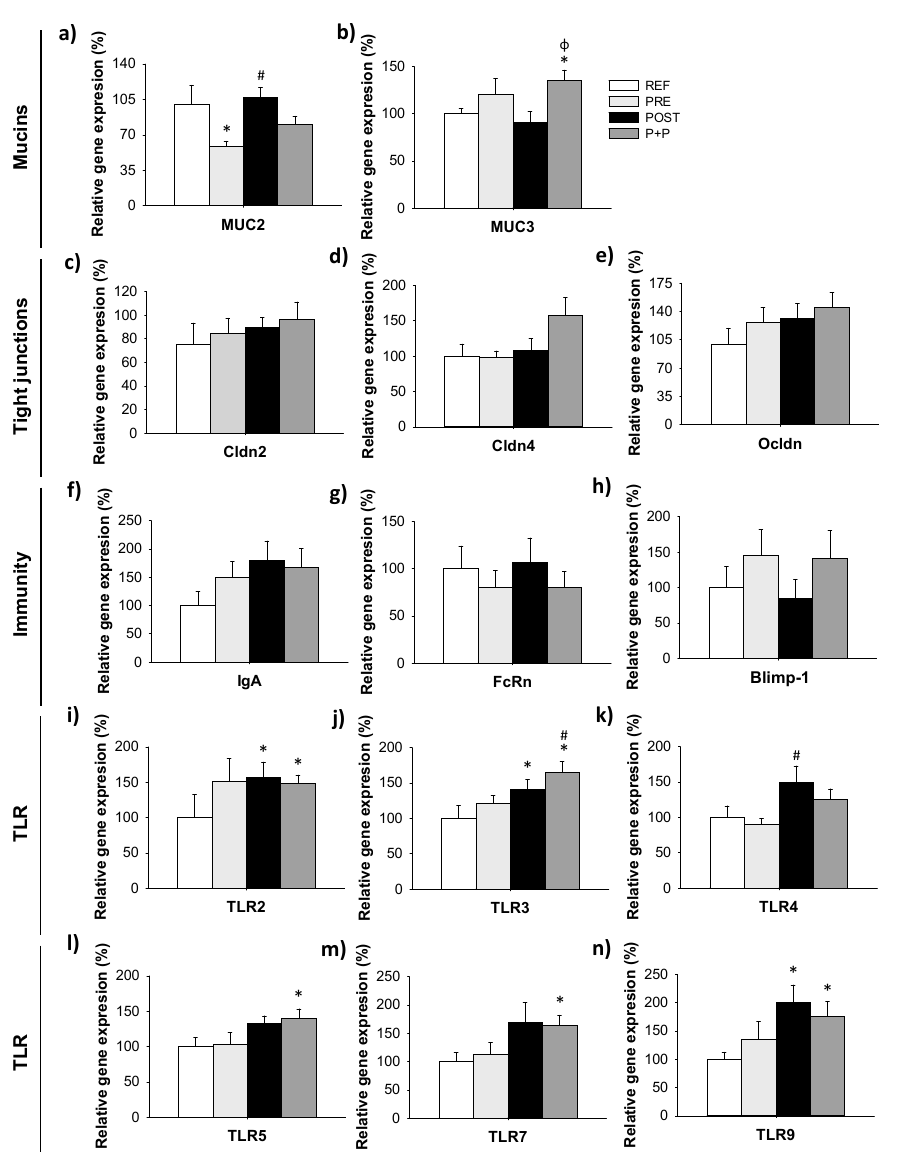
Figure 3. Relative gene expression of mucin (MUC) 2 ( a ) and MUC 3 ( b ), tight junction proteins claudin (Cldn) 2, Cldn4 ( c , d , respectively) and occludin (Ocldn) ( e ), immunity related molecules IgA ( f ), FcRn ( g ) and Blimp-1 ( h ) and Toll-like receptors (TLR) 2 ( i ), TLR3 ( j ), TLR4 ( k ), TLR5 ( l ), TLR7 ( m ) and TLR9 ( n ) was quantified by real-time PCR on day 16. Relative gene expression was calculated with respect to REF animals, which corresponded to 100% of transcription. Results are expressed as mean ± S.E.M. (n = 8–9 animals/group). Statistical significance: * p < 0.05 vs. REF, # vs. PRE and φ vs. POST. REF: reference group; PRE: group supplemented with a mixture of scGOS and lcFOS; POST: group